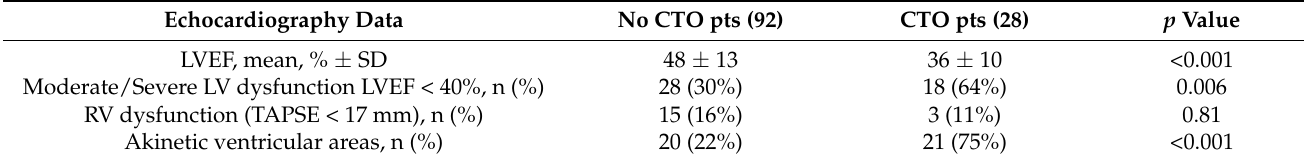
Table legend: CTO: Coronary total occlusion; LVEF: left ventricular ejection fraction; TAPSE: tricuspid annular plane